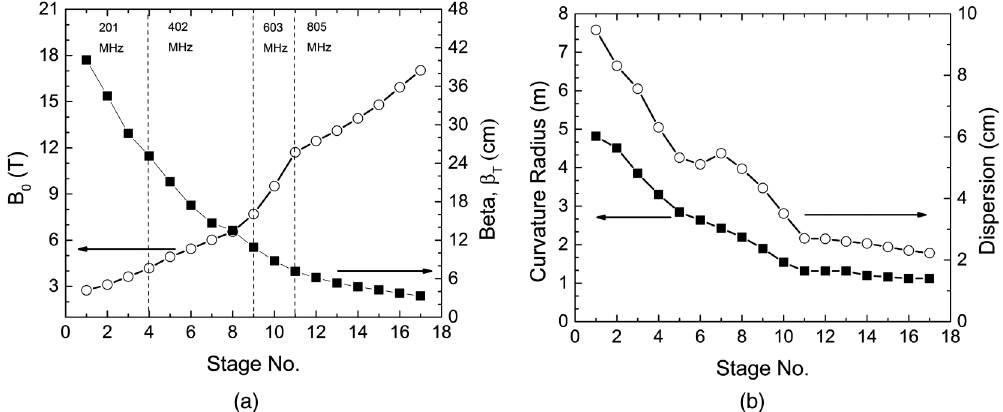
FIG. 6. (a) Design value of beta function (right) and maximum value of the on-axis solenoid field; (b) radius of curvature and dispersions at various stages of our ziggurat